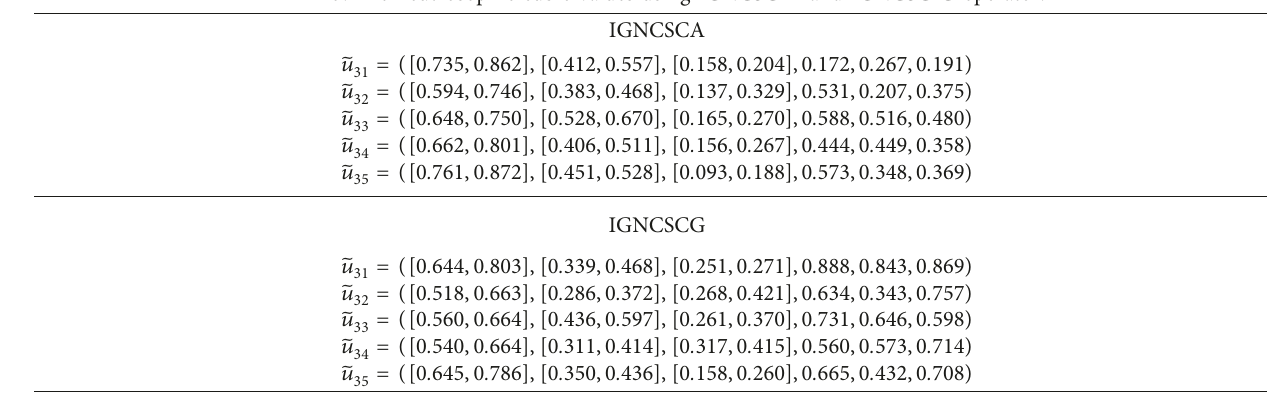
Table 3: The neutrosophic cubic values using IGNCSCIA and IGNCSCIG operator.